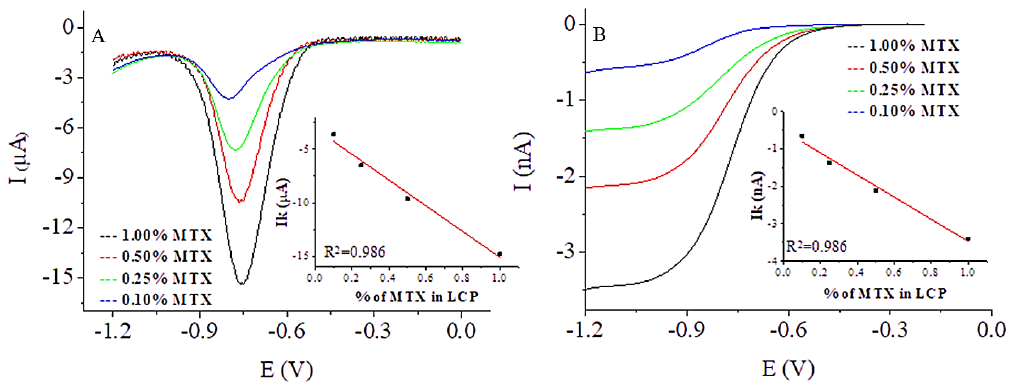
Figure 3. DPV recorded from a GCE ( A ) and CV from a GC microelectrode ( B ) modified with the cubic phase containing 1.00, 0.50, 0.25, and 0.10% w / w of MTX at pH 7.4. Inset: Dependence of the MTX response on the drug concentration in the LCP.